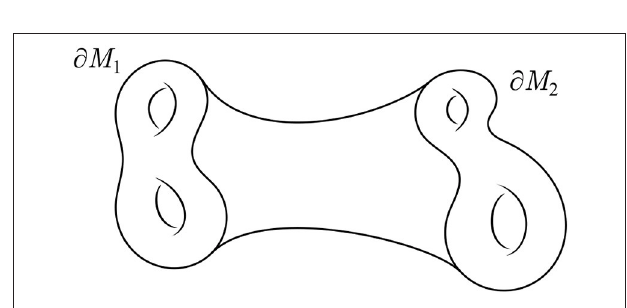
FIGURE 10 | Illustration of a 3d euclidean AdS wormhole geometry with the two boundary components ∂ M 1 and ∂ M 2 corresponding to Riemann surfaces ( Maldacena and Maoz, 2004; Hubeny et al.,